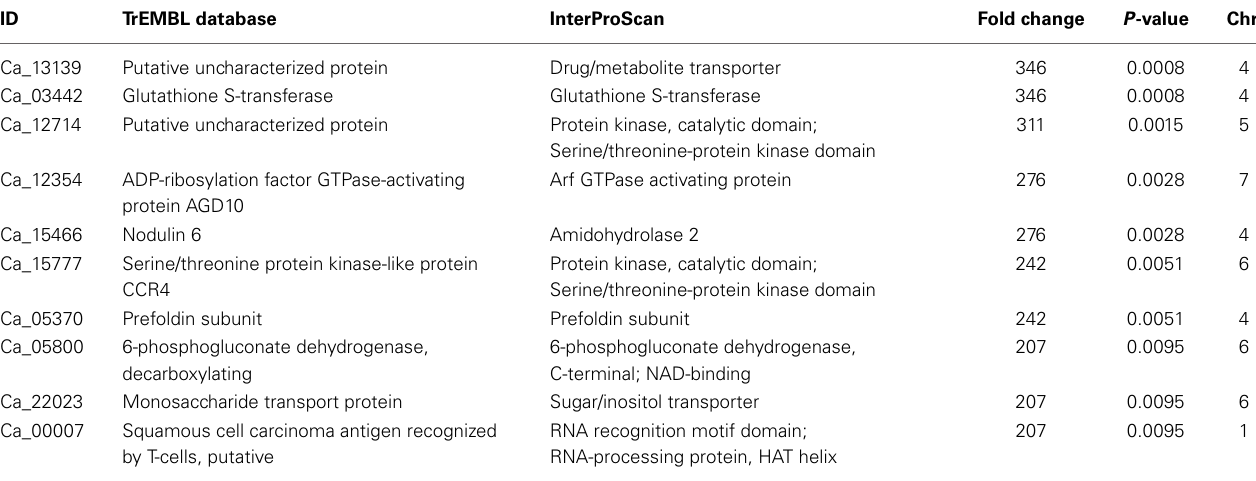
Table 3 | Proteins encoded by the 10 most upregulated genes from nodule compared to root tissue of chickpea cultivar Beja 1.